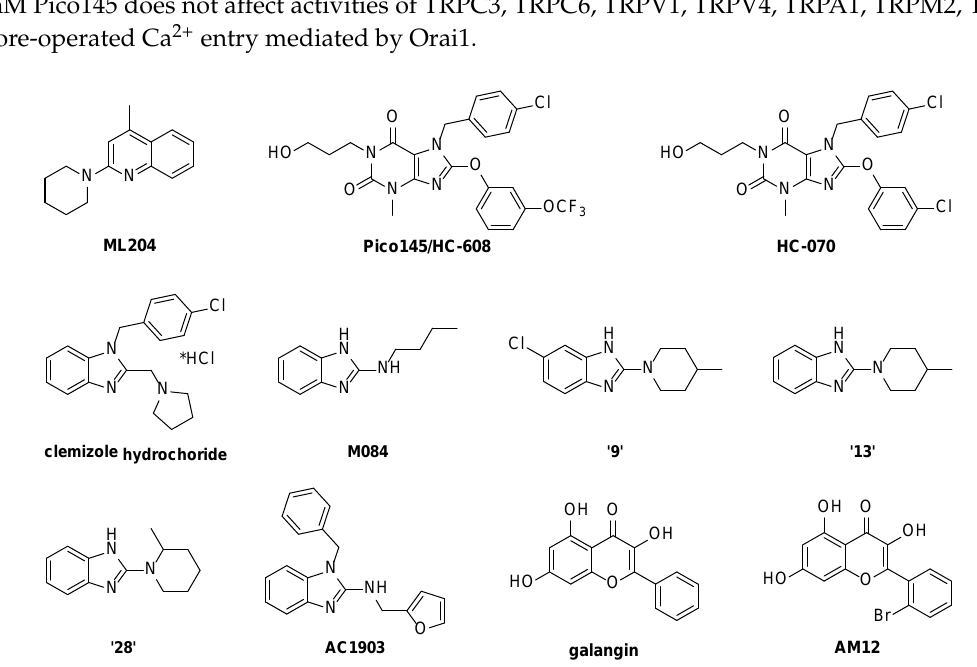
Figure 4. Structures of ML204 and recently reported TRPC1/4/5 inhibitors.